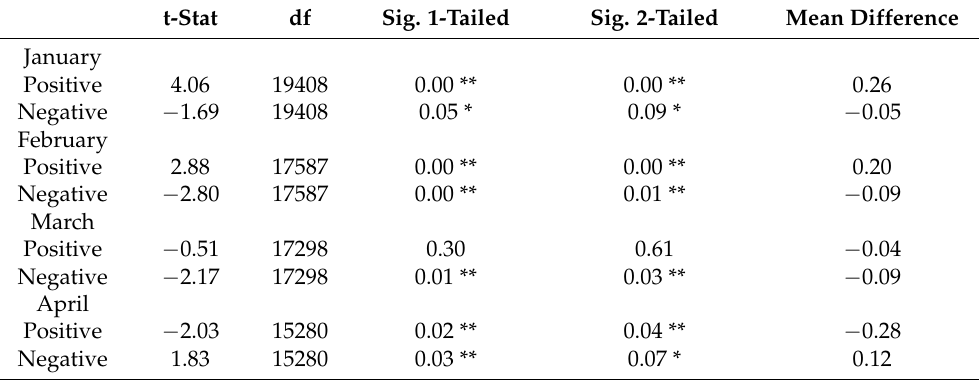
Table 1. t-test of Two Affection Extremes between 2020 and the Average of 2017–2019 by Month. t-Stat